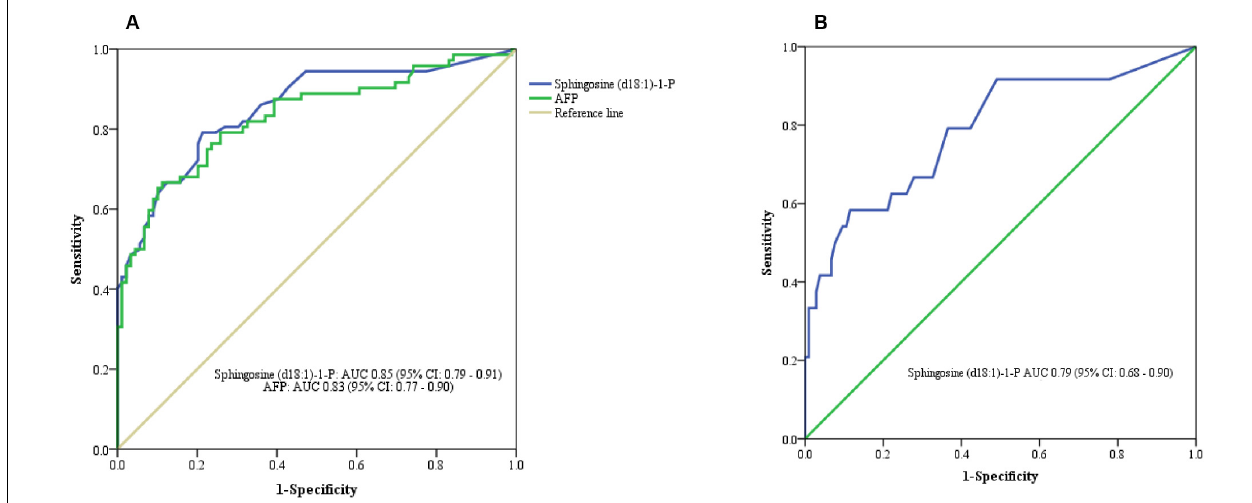
FIGURE 4 | ROC curve analysis. (A) Serum Sphingosine (d18:1)-1-P for differentiating HCC from cirrhotic patients. (B) Serum Sphingosine (d18:1)-1-P for differentiating APF-negative HCC from cirrhotic